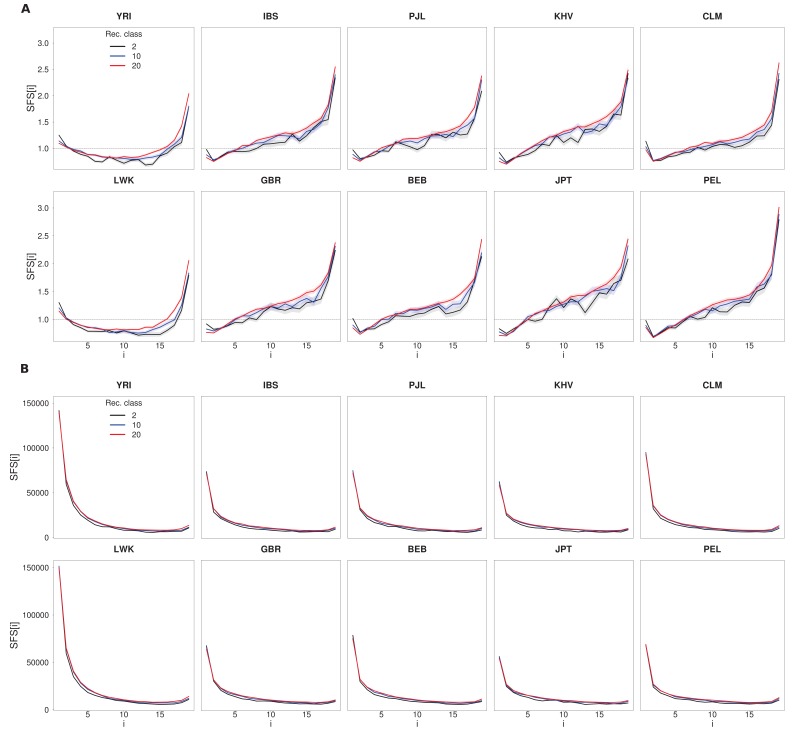
SFS of ten 1000G populations for sites belonging to three recombination classes.Recombination classes 2 (low), 10 (medium), and 20 (high) correspond to the respective recombination bins as defined in the main text. (A) Normalized unfolded SFS, (B) unfolded SFS. Low-recombination classes show increased singleton frequencies and a lower proportion of intermediate- and high-frequency variants. For each panel, pairwise comparisons of the SFS are significant with p-values<10–3 (see Materials and methods). Shaded areas correspond to 95% CI obtained by a block-bootstrap approach (see Materials and methods).